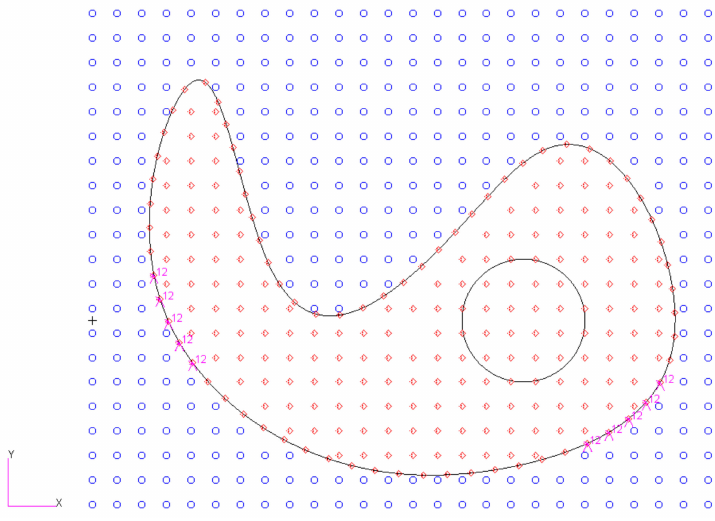
Figure 7. Removed nodes (blue) and field nodes (red) in a predesigned domain with a